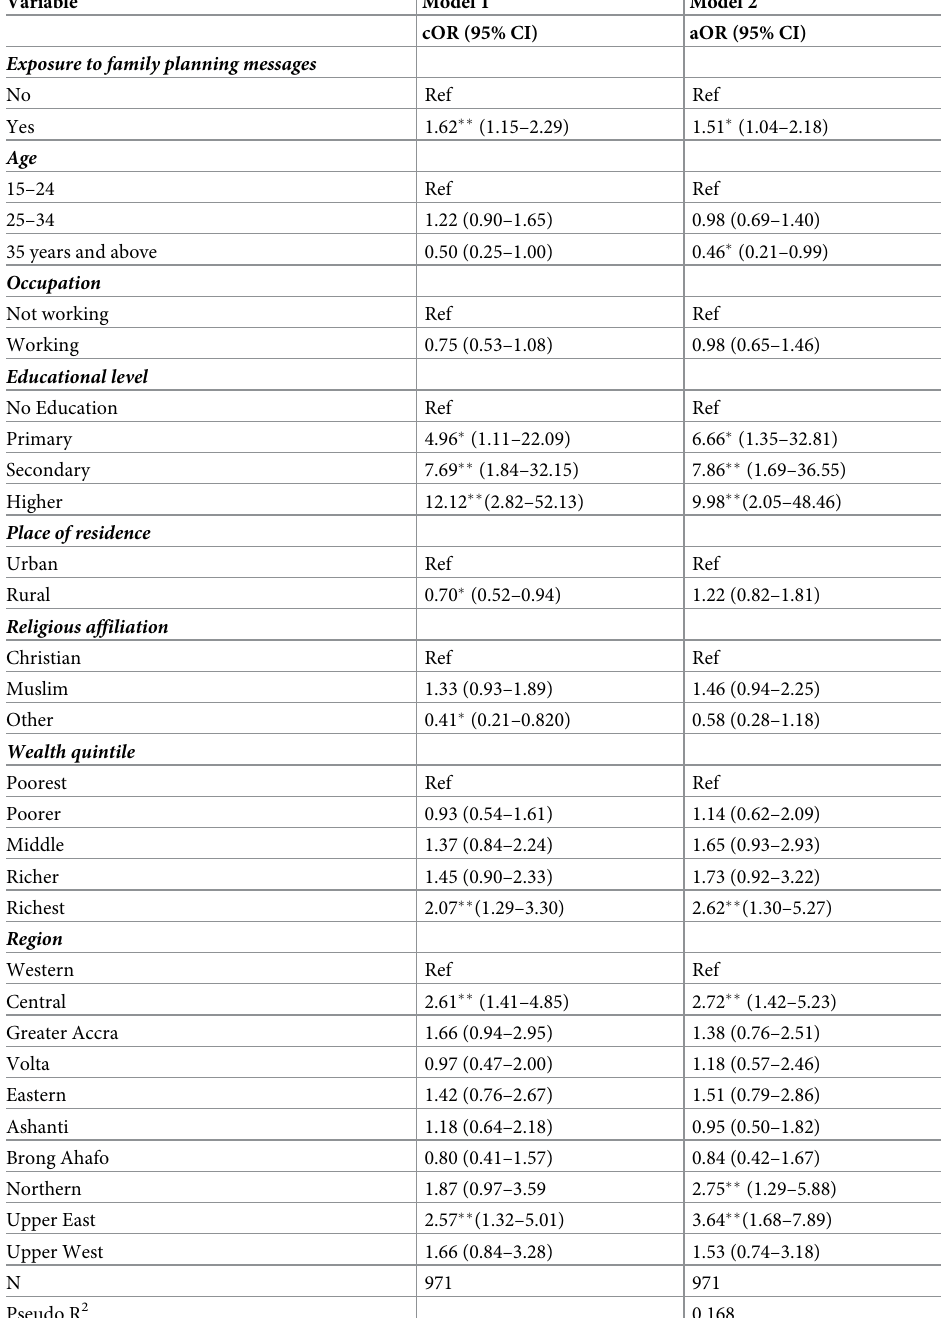
Table 2. Influence of exposure to family planning messages and socio-demographic characteristics on consistent condom use among sexually active men in